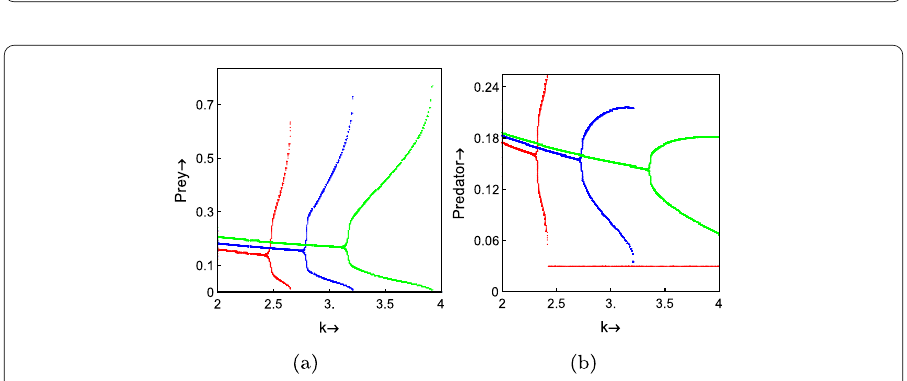
Figure 5 The bifurcation diagram by fixing m = 0.18 (red curve), m = 0.2 (blue curve), m = 0.22 (green curve) and varying k in (2,4). The existence of limit cycle (Hopf bifurcation) for various values of